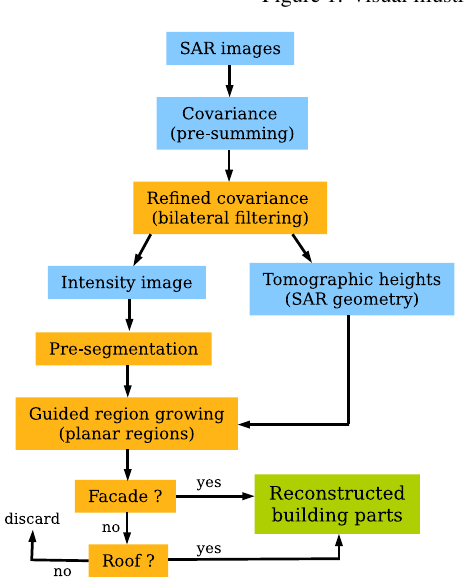
Figure 1: Visual illustration of the main steps in our method.